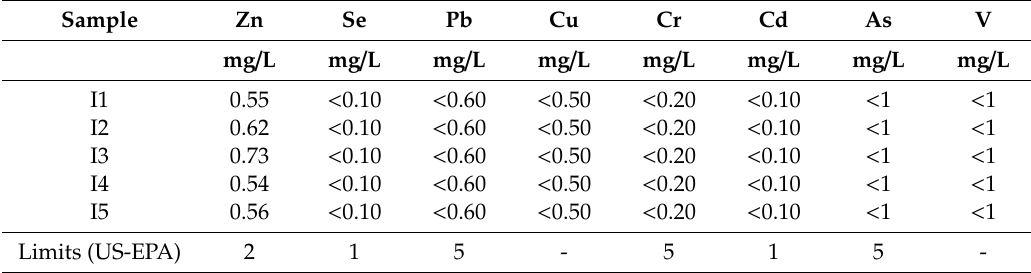
Table 3. Results of the Toxicity Characteristic Leaching Procedure (TCLP) of